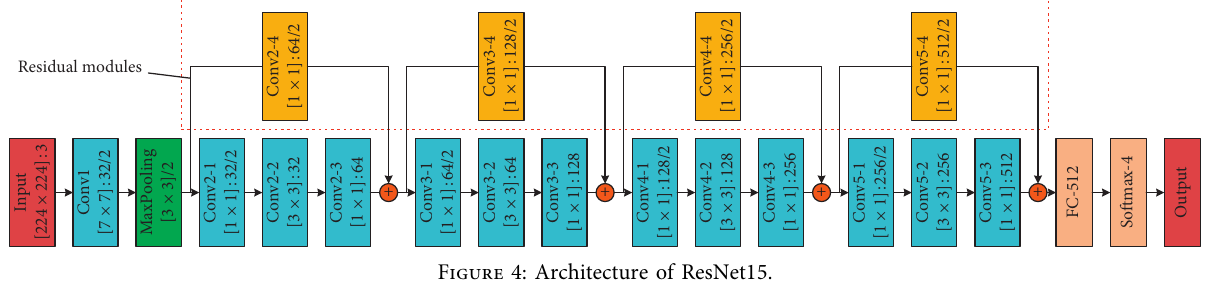
Figure 4: Architecture of